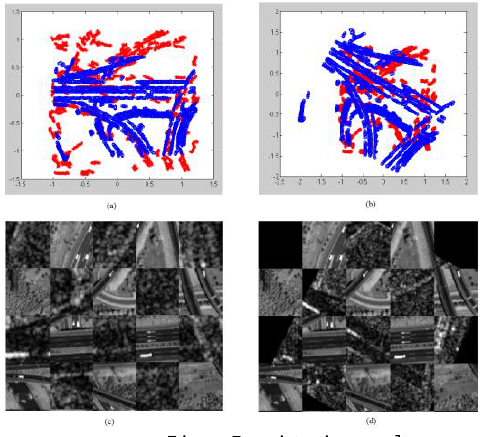
(a) Point set registration result of our method. (b) Point